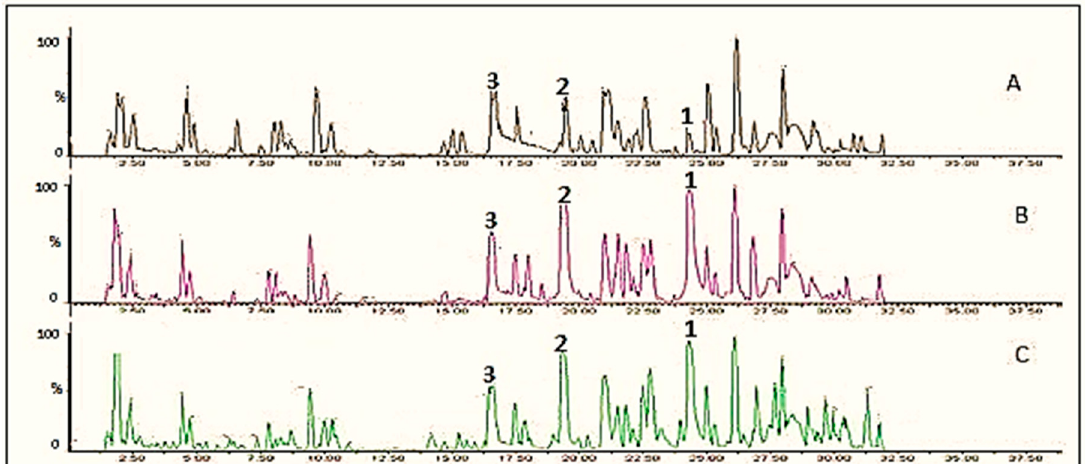
Figure 2. UPLC chromatograms of onion extract, A , control; B , fermented with Rhizopus oryzae for 1 day; C , fermented with Rhizopus azygosporus for 1 day. The numbers indicate the following compounds: 1 = quercetin; 2 = quercetin-3-O-glucoside, 3 = quercetin-3-O-glucoside-7-O-glucoside. Table 1. Identification of flavonoid compounds selected from cauliflower outer leaves and onion extract. m / z Values Extract Rt (min)